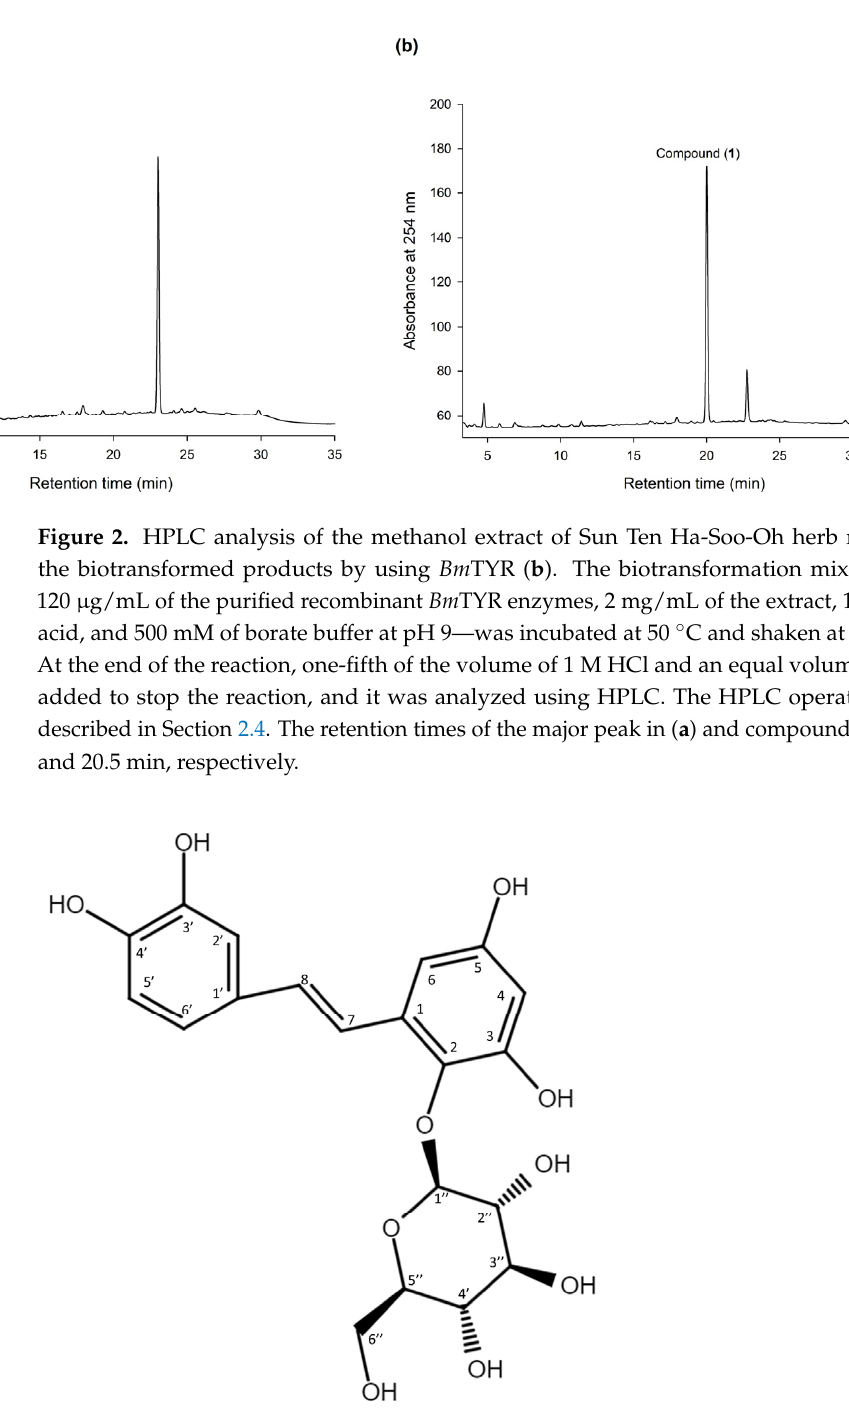
Figure 1. High-performance liquid chromatography (HPLC) analysis of the methanol extracts (5 mg/mL) from four different brands, Sun Ten ( a ), Ko Da ( b ), Chuang Song Zong ( c ), and Min Tong ( d ), of Ha-Soo-Oh herb medicine. The HPLC operation procedure is described in Section 2.4.